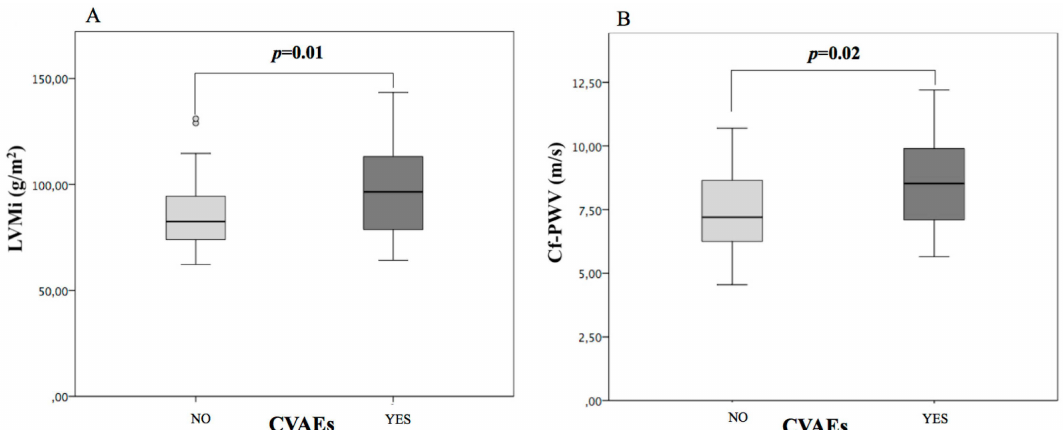
Figure 1. Cardiovascular organ damage in patients with and without cardiovascular adverse events during follow up. LVMi = left ventricular mass indexed to body surface area ( A ); cf-PWV = carotid-femoral pulse wave velocity ( B ). CVAEs = cardiovascular adverse events.